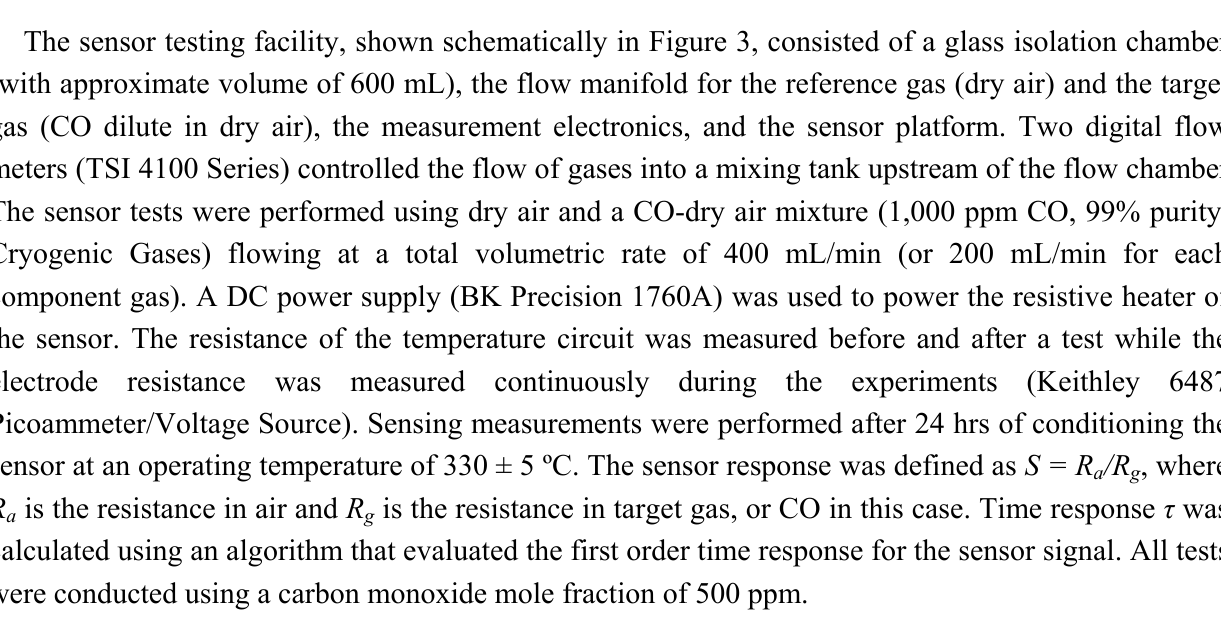
Figure 3. Schematic of the sensor test